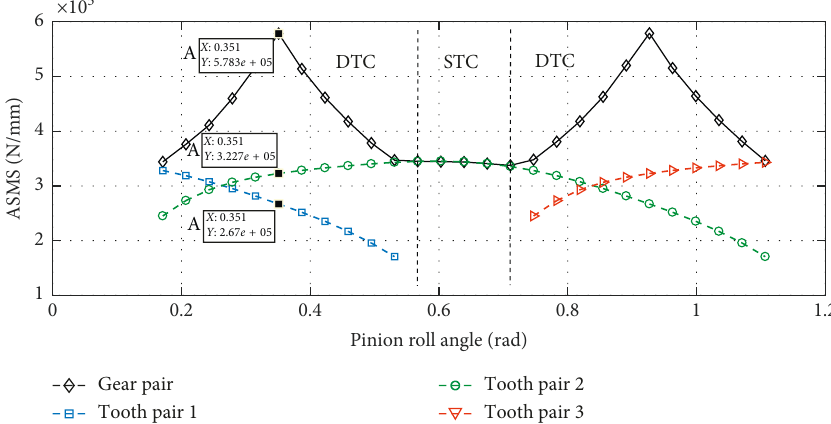
Figure 12: The ASMS of the gear pair and the tooth pair over one tooth engagement cycle at 300 Nm applied torque.